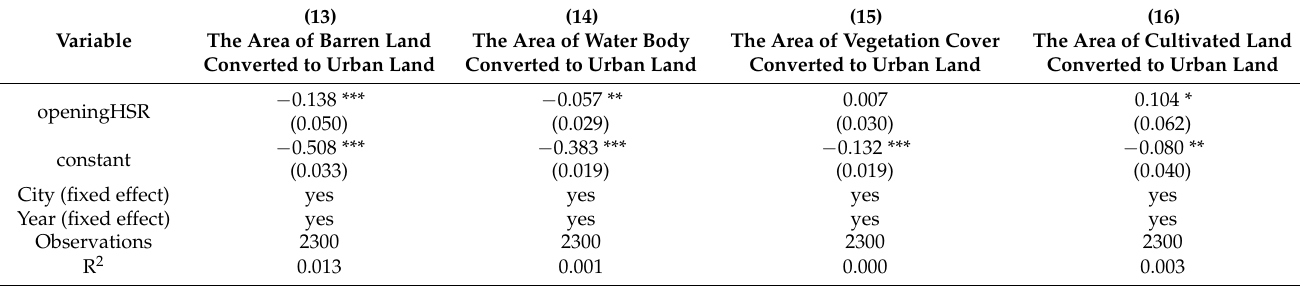
Table 6. The impact of the first opening of HSR on the conversion of non-urban land to urban land.